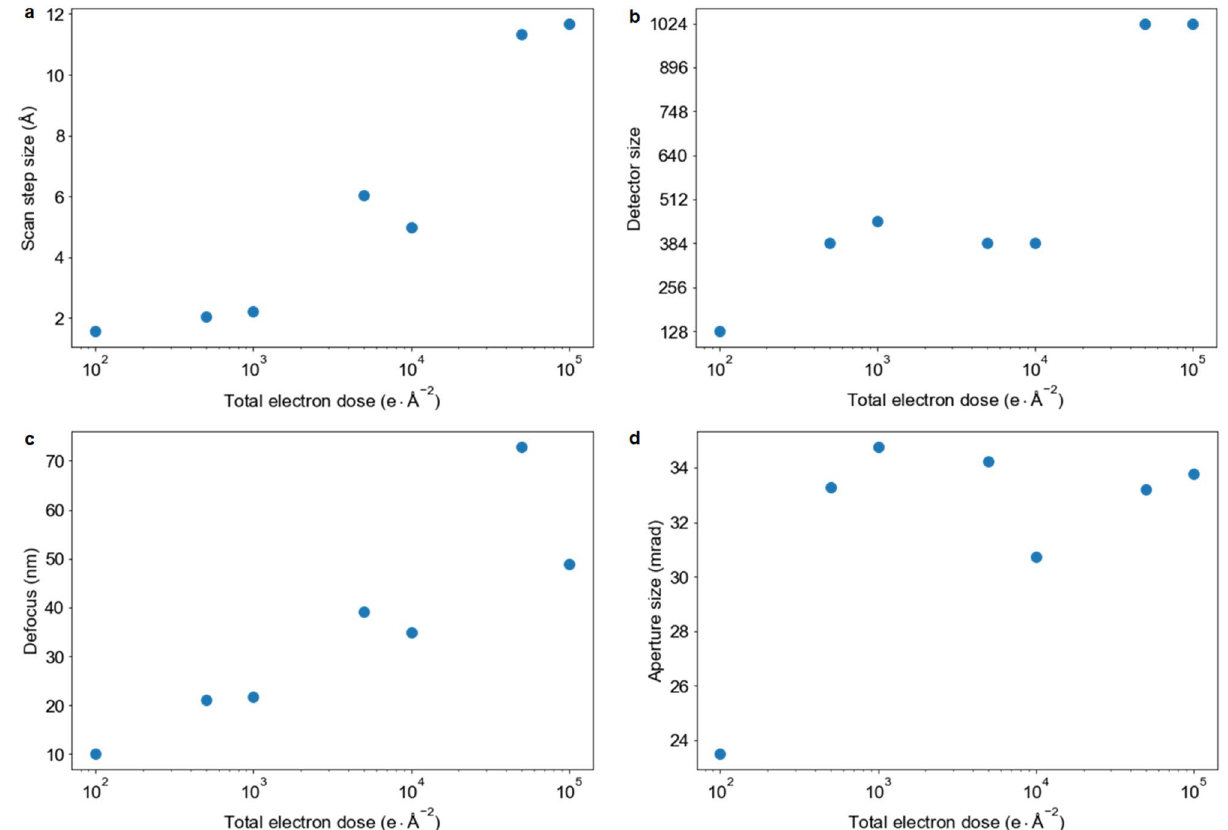
Figure 6. Optimal experimental parameters for electron ptychography. At each electron dose level, BO attempts to optimize scan step size ( a ), detector size ( b ), probe defocus ( c ), and aperture size ( d